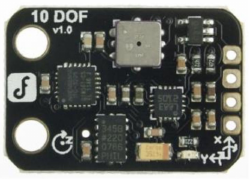
Figure 5. The 10 DOF MEMS